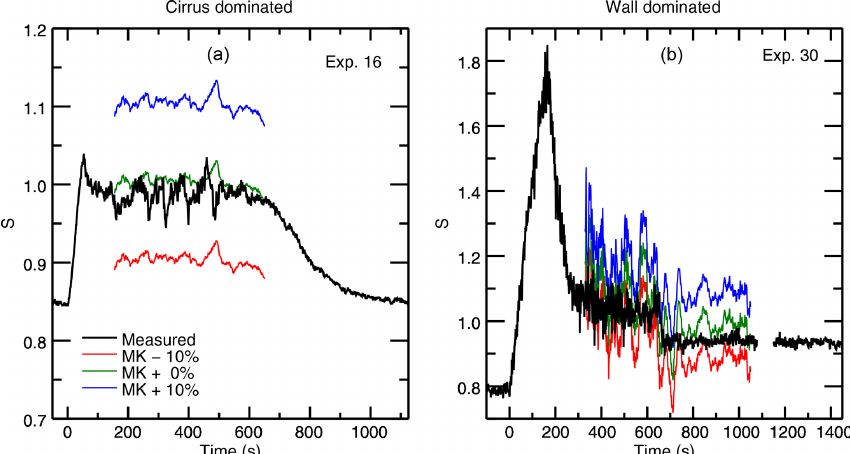
Figure 4. Model output for experiments used in the previous example: the cirrus-dominated Experiment 16 (a) and wall-dominated Experi- ment 30 (b) . Each output is calculated using observed quantities under three different assumptions about the “true” saturation vapor pressure of cirrus. The red line assumes the true value is 10% lower than the MK saturation vapor pressure, the blue line assumes it is 10% higher, and the green line assumes MK is the true saturation vapor pressure. Calculated saturations are smoothed by 30 points ( ∼ 30s). Measured saturations are unsmoothed. Experiments are very sensitive to the assumed vapor pressure, although wall-controlled experiments are noisier overall since they are typically at lower temperatures. Experiment 16 shows spikes in measured water which are due to real sampling of different air masses during the turbulent period when the pumps are on and the cirrus cloud is growing. Experiment 30 shows oscillations in the model output due to in-mixing of warmer air from the top of the chamber. This type of temperature fluctuation is not captured by the